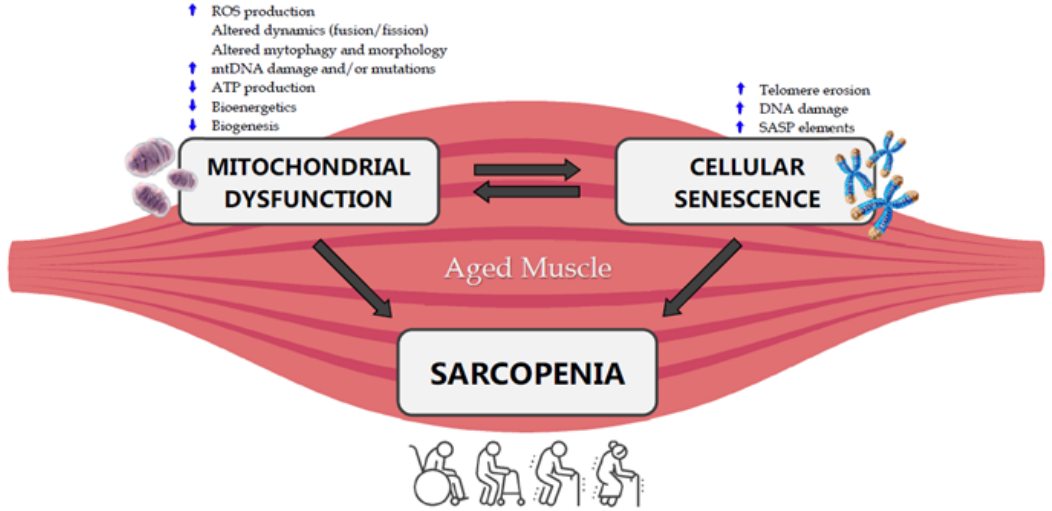
Figure 1. Crosstalk between mitochondrial dysfunction, cellular senescence and sarcopenia in the aged muscle. ROS: Reactive Oxygen Species, mtDNA: mitochondrial DNA, ATP: Adenosine Triphosphate, SASP: Senescence-Associated Secretory Phenotype.